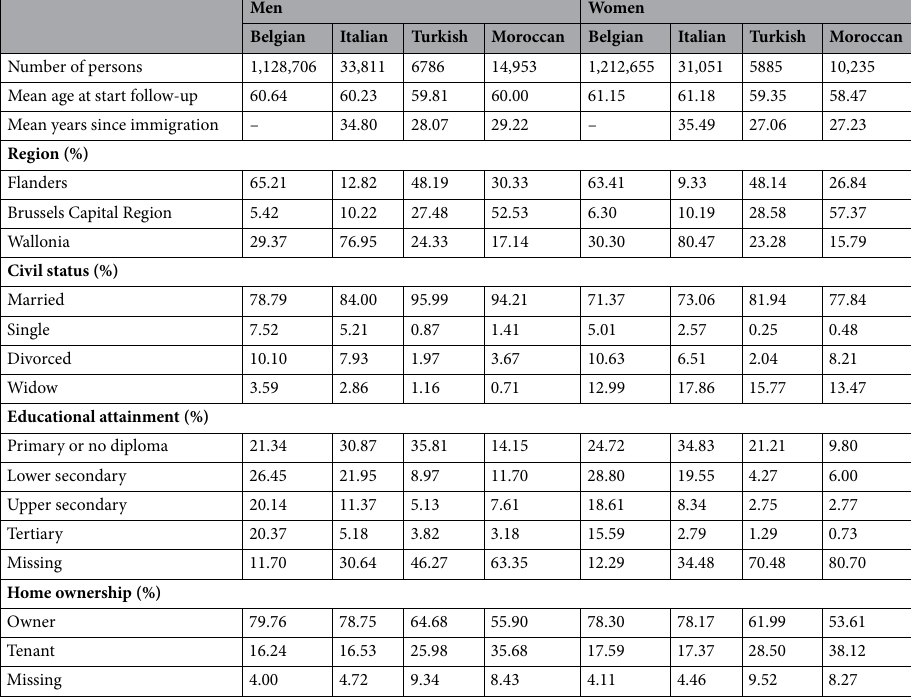
Table 1. Description of the study population aged 50 to 74 years at the start of the follow-up (January 1st 2004), by gender and migrant origin, Belgium.